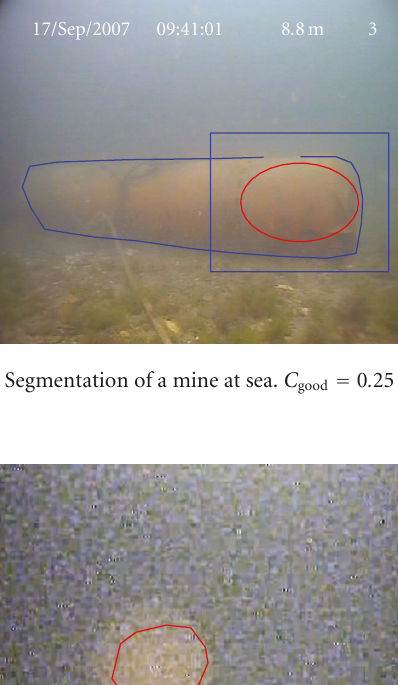
Master Figure 17: Segmentation of a mine using the feature map selected by maximum activity. C good = 0 . 26 and C false = 0 .